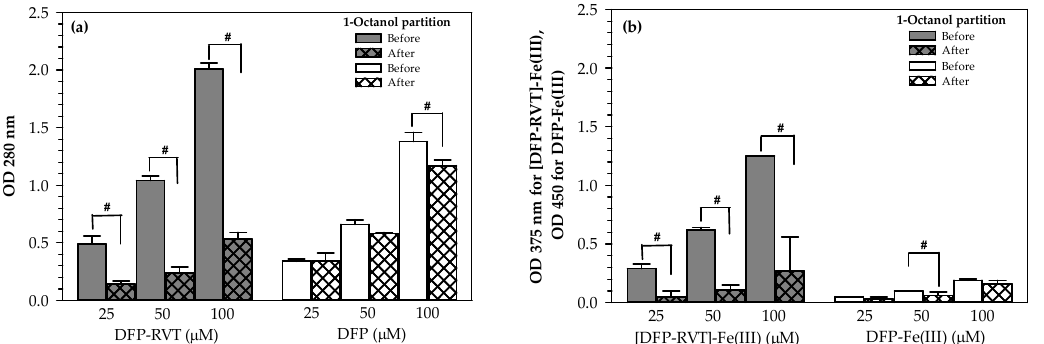
Figure 2. Partition of DFP-RVT, DFP, [DFP-RVT]-Fe(III) complexes and the DFP-Fe(III) complex in a water/octanol solvent. ( a ) DFP and DFP-RVT (0–100 µM each) solutions were partitioned in 1-octanol and centrifuged, while their aqueous phases were measured in terms of optical density (OD) at 280 nm using spectrophotometry. ( b ) DFP-RVT and DFP (0–100 µM each) solutions were incubated with ferric ammonium citrate solution and then partitioned in 1-octanol and centrifuged, while their aqueous phases were measured in terms of OD at 375 and 450 nm, respectively, using spectrophotometry. OD values obtained from three repetitions are expressed as mean ± standard deviation (SD) values. Statistical significance was determined using an analysis of variance test, for which a p -value of <0.05 was considered significant. # p < 0.05 when compared before and after the addition of 1-octanol.